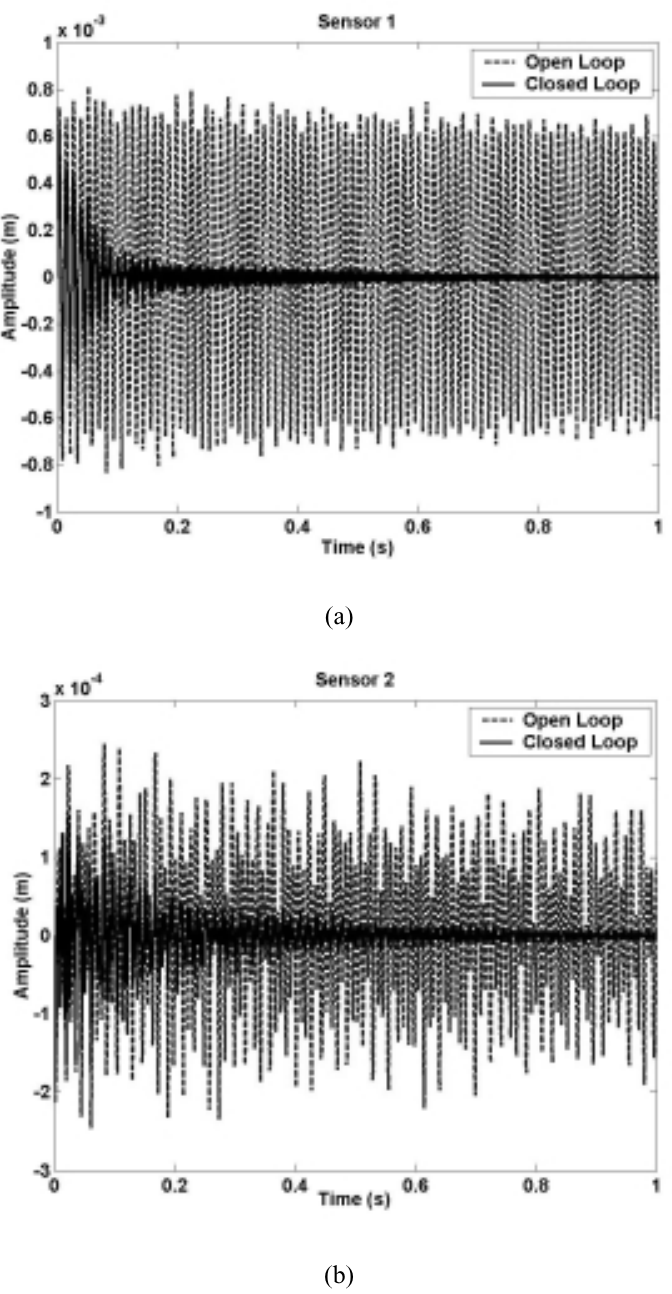
Fig. 5. Uncontrolled and controlled response for the structure at (a) sensor 1 and (b) sensor 2, when the IMSC strategy is